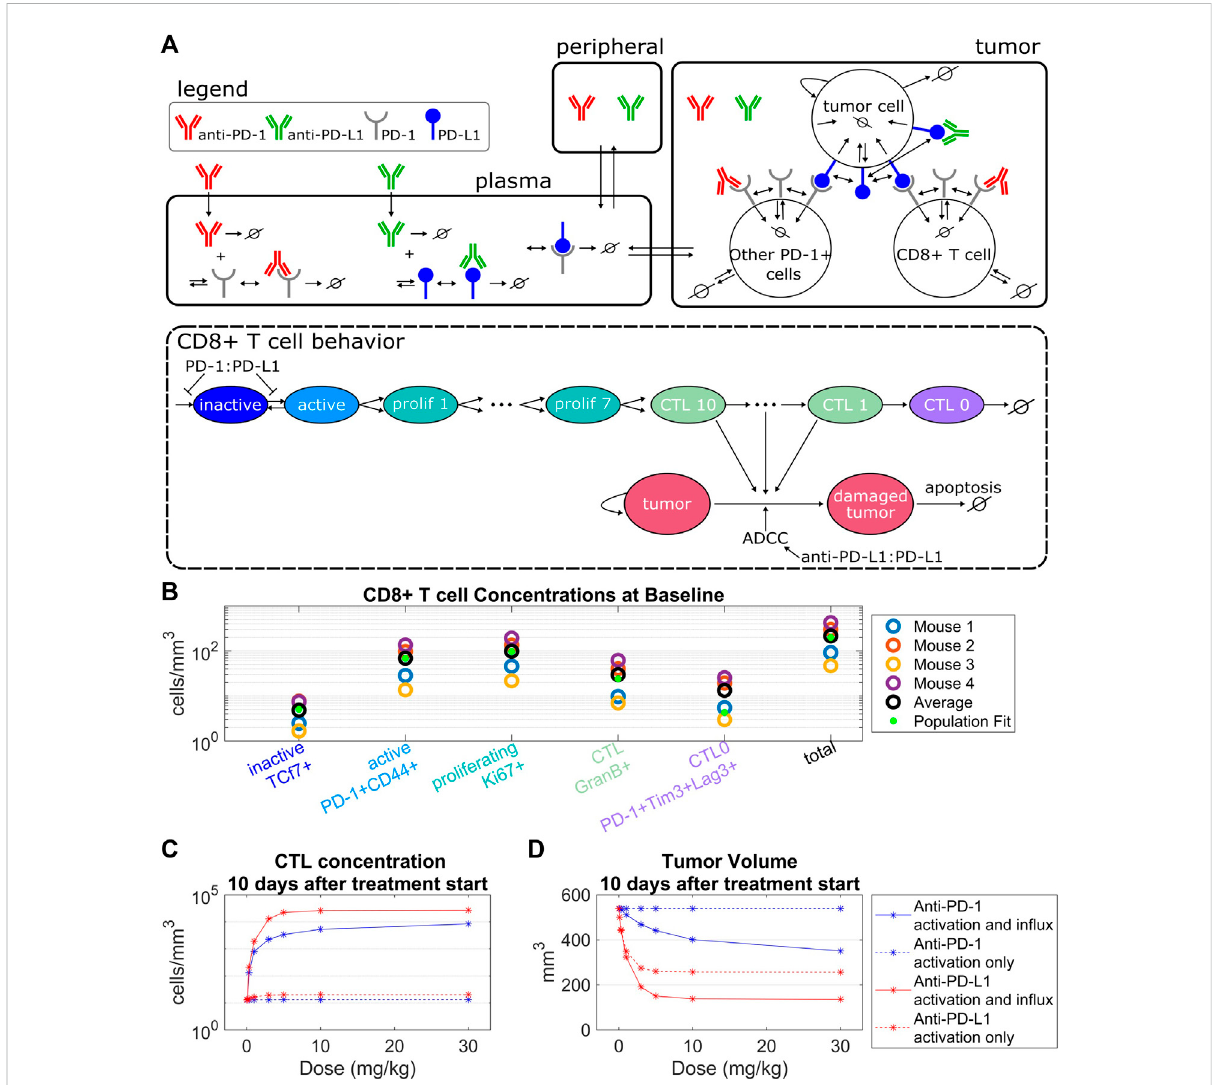
FIGURE 1 Model structure captures intra-tumoral T cell dynamics from in vivo data. (A) The QSP model consists of three compartments that describe the pharmacokinetics of anti-PD-(L)1, molecular interactions of the antibodies with their targets, cellular kinetics and interactions of CD8 + T cells and tumor cells. The life cycle of the CD8 + T cells is depicted in the QSP model. (B) CD8 + T cell concentrations from fl ow cytometry data of four mice plotted with the model simulated steady state concentrations using the population fi t parameter set. Simulated steady state values of T cell concentrations are depicted by green dots. (C,D) Percent changes in CTL concentrations (C) and tumor volumes (D) from the control simulation 10 days after treatment start for the model with constant CD8 + T cell in fl ux vs. the model with PD-1:PD-L1 binding dependent CD8 + T cell in fl